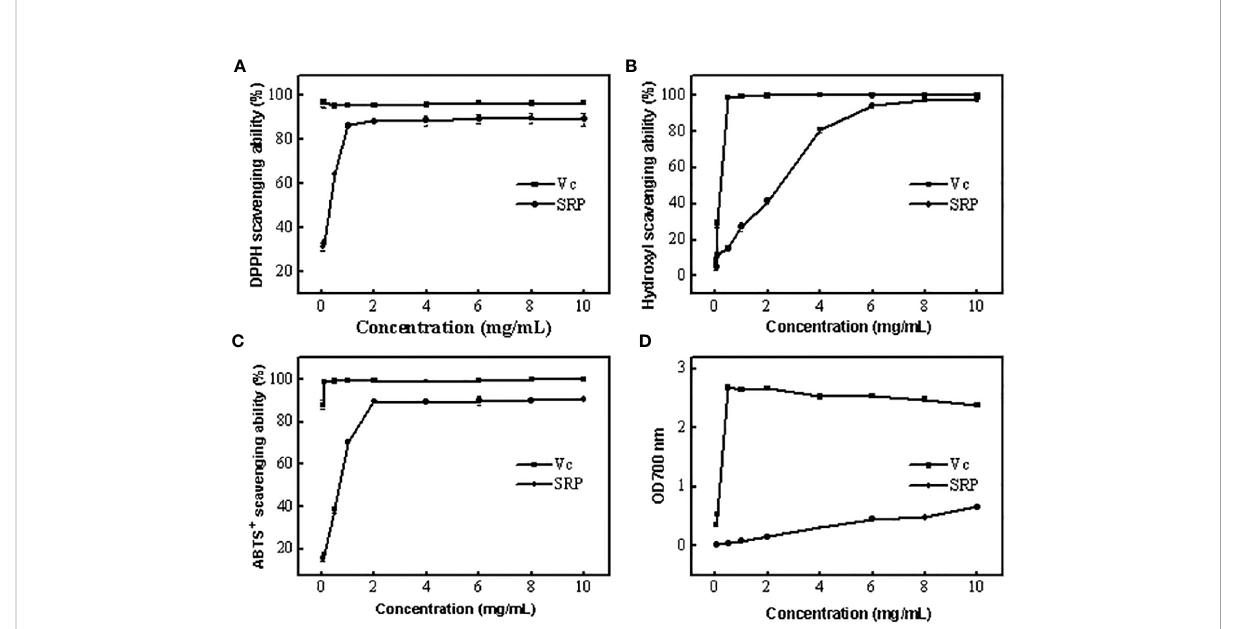
FIGURE 3 Antioxidant activity of SRP (A-D) DPPH, Hydroxyl, ABTS + radical scavenging ability and reducing power.